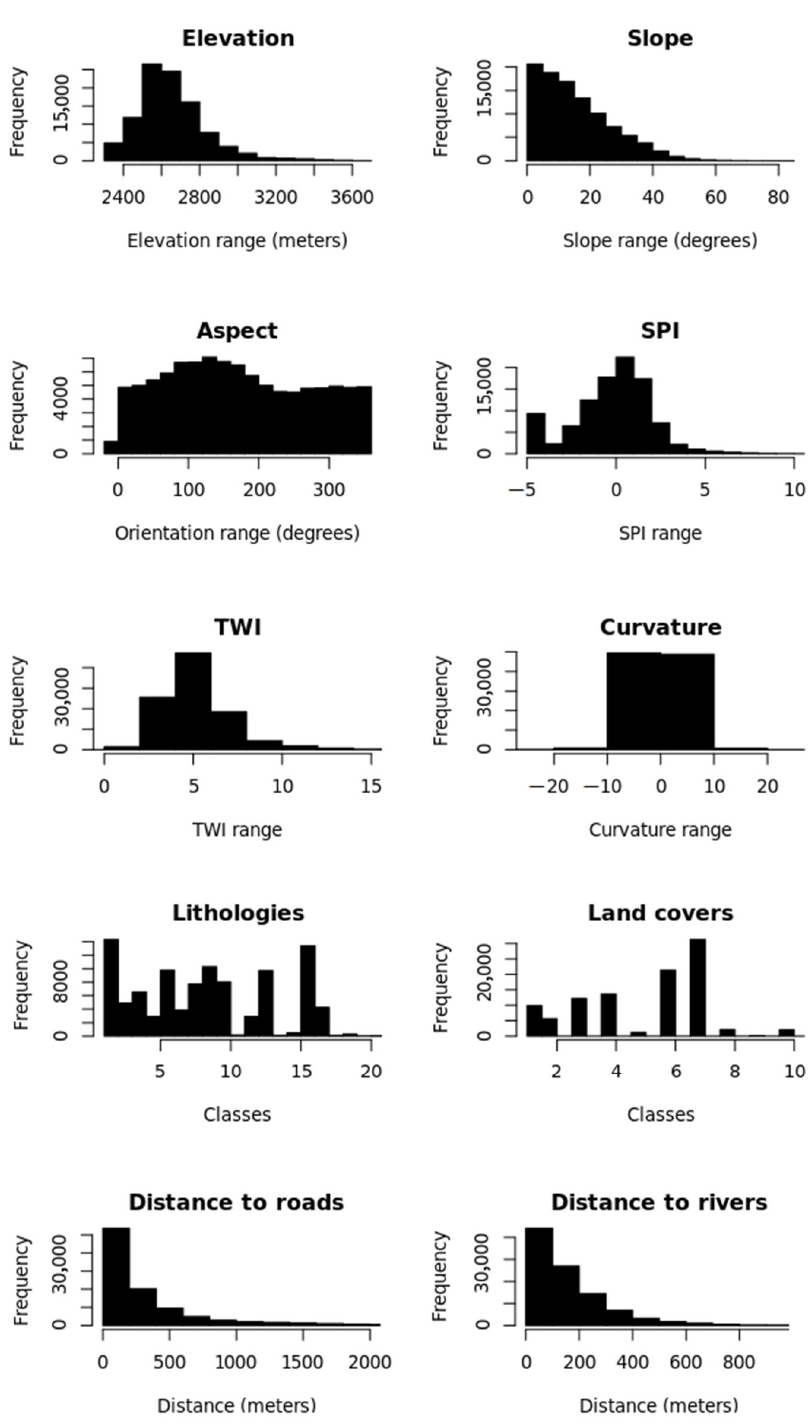
Figure 5. Distributions of conditioning factors in study zone.